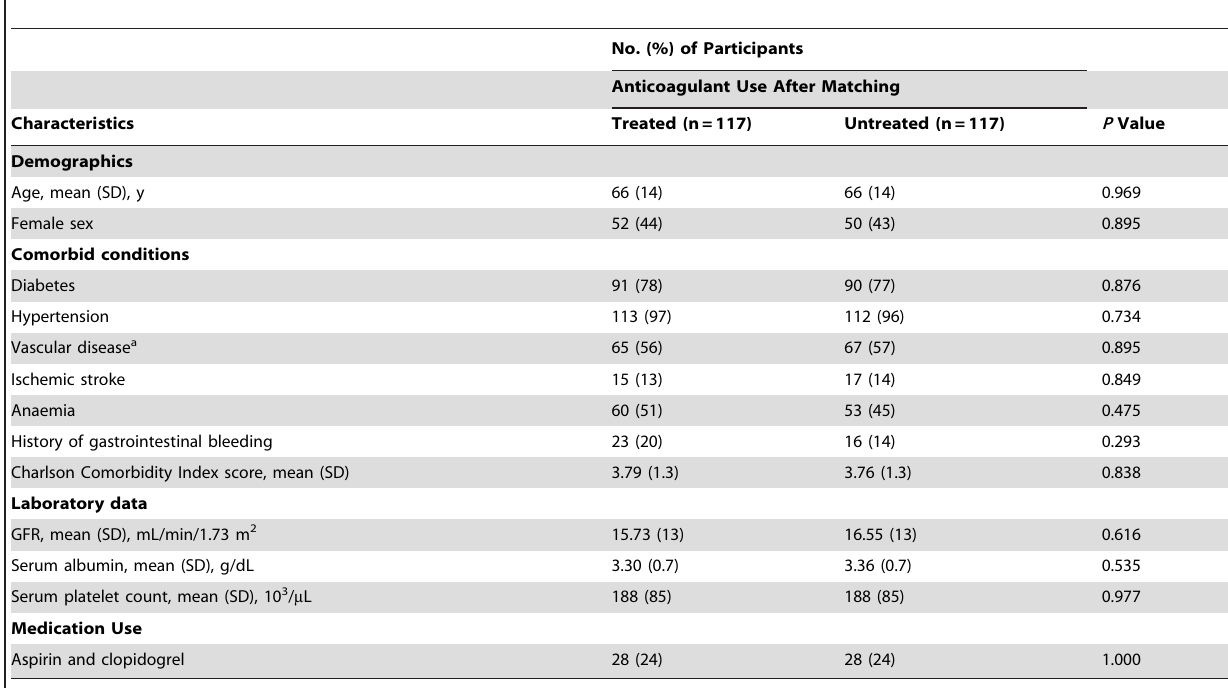
Table 2. Characteristics of patients with and without anticoagulant use after propensity matched analysis.